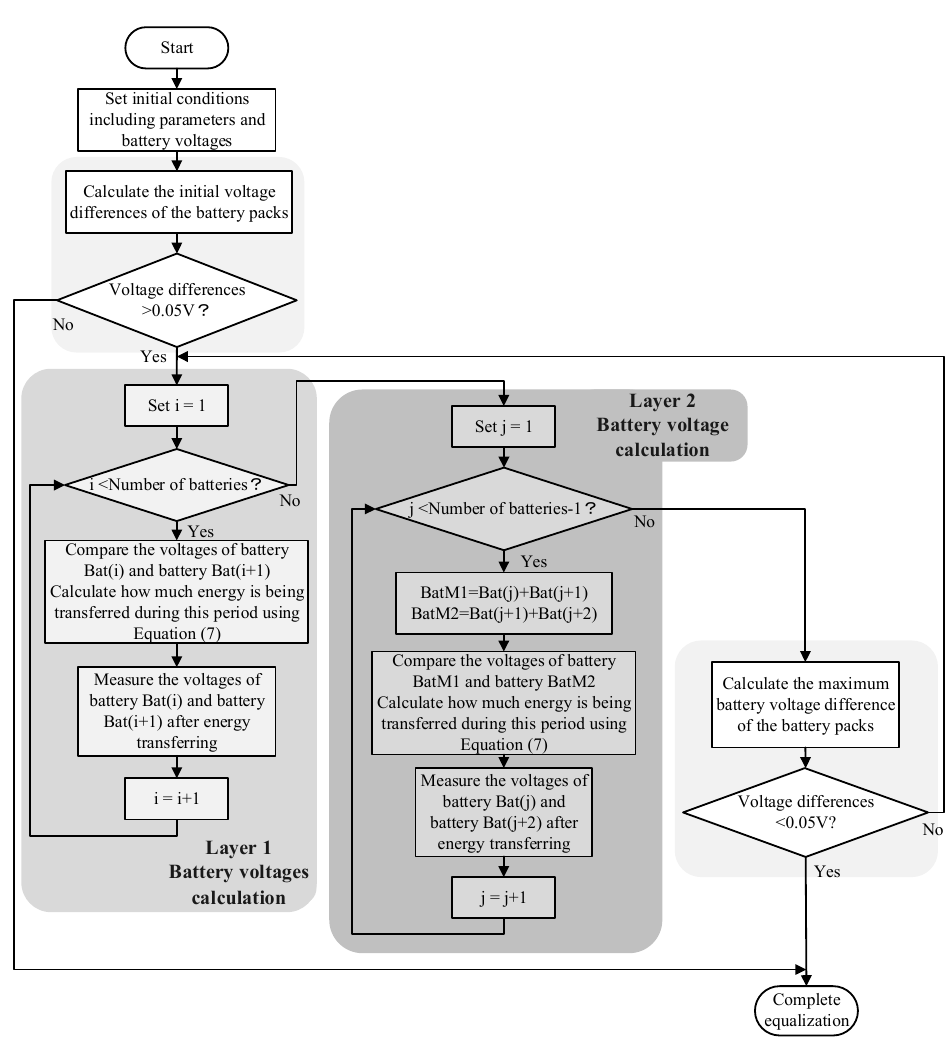
Figure 11. Flowchart of the double-tiered SC-based